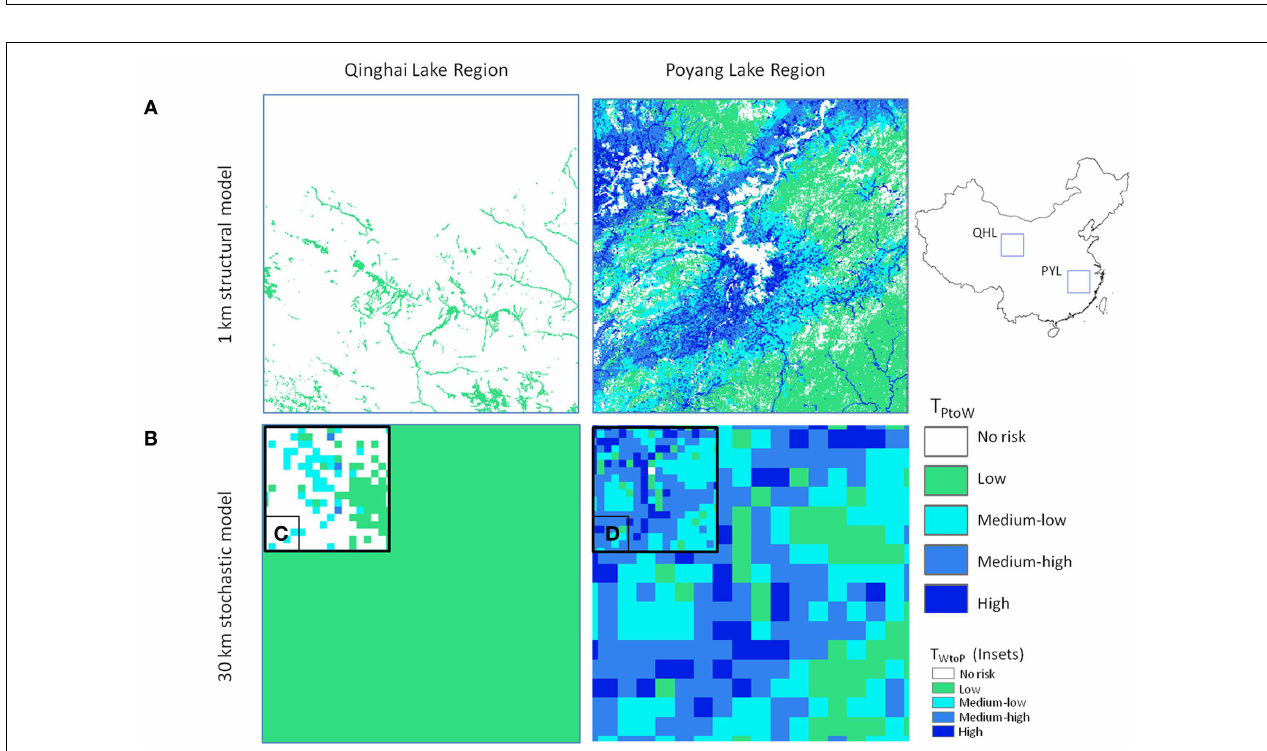
FIGURE 4 | H5N1 transmission risk between wild and domestic birds in China and associated uncertainty predictions at 30km resolution . Risk maps represented as mean and CV (left and right in each pair of maps, respectively). (A) Top panel represents transmission risk from